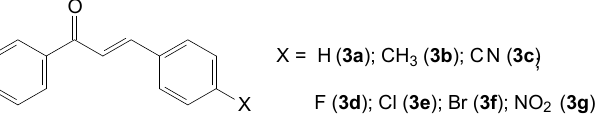
Figure 2. Chemical structure for the synthetic chalcones 3a – g .